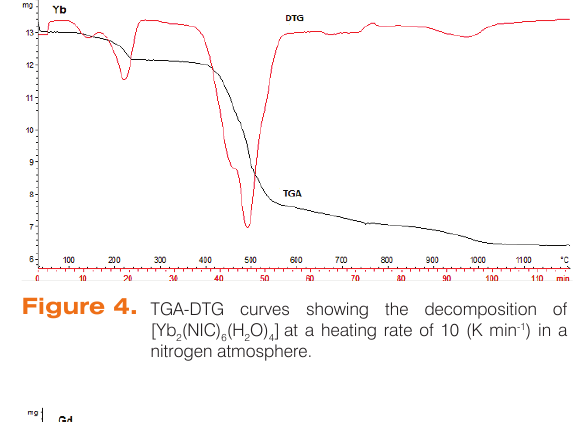
Figure 4. TGA-DTG curves showing the decomposition of [Yb